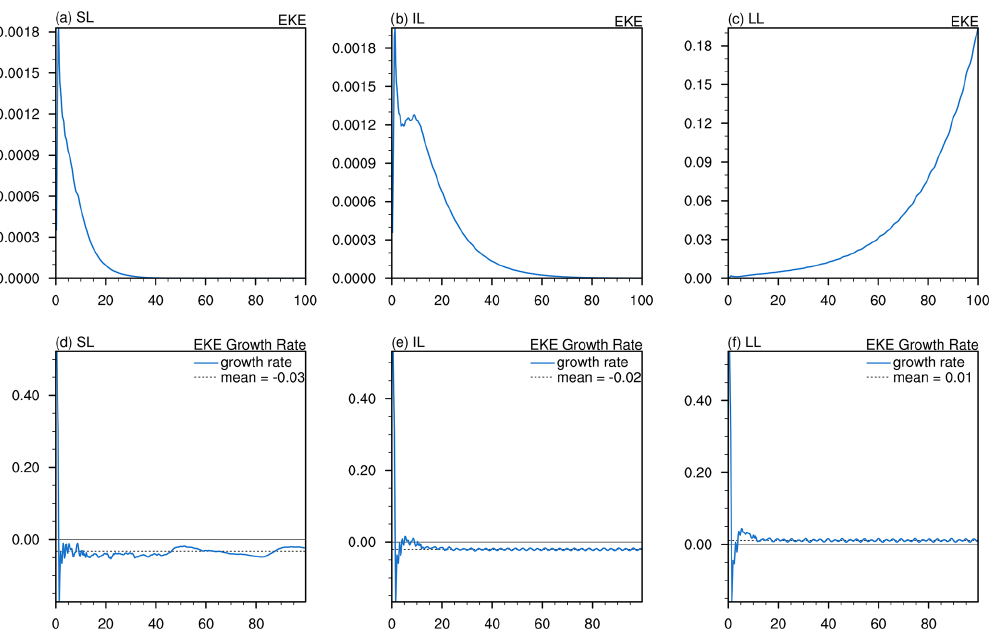
Figure 12. Time series of the globally averaged EKE ( a–c , Jkg − 1 ) and growth rates ( d–f , d − 1 ) resulting from the fixed-heating anomaly on the short- (a, d) , intermediate- (b, e) , and long-lived (c, f) basic states. The mean growth rate, averaged over the last 50d of the simulation, is shown by the dashed line.